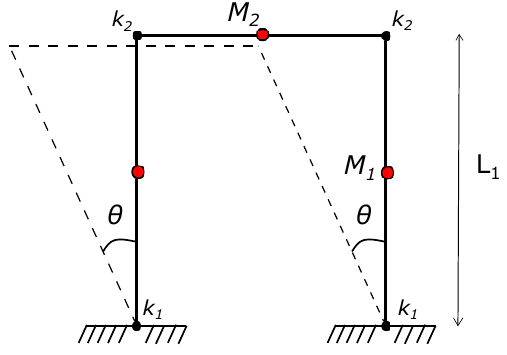
Figure 6. Model of the